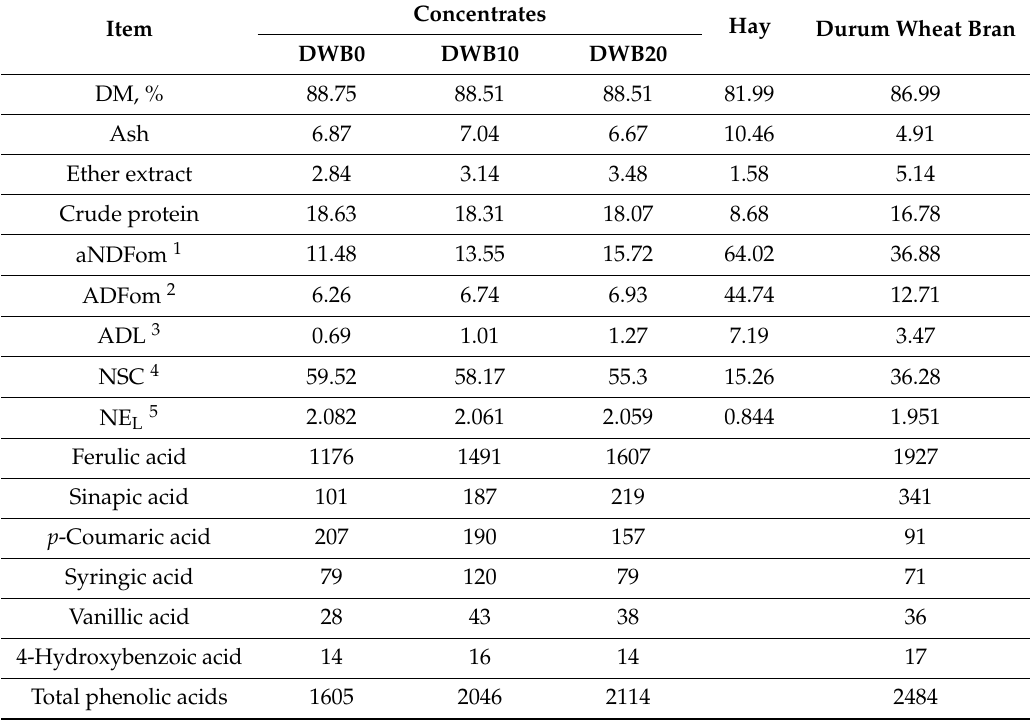
Table 2. Chemical composition (% DM), net energy value (Mcal / kg DM) and phenolyc acids content ( µ g / g DM) of feeds used during the